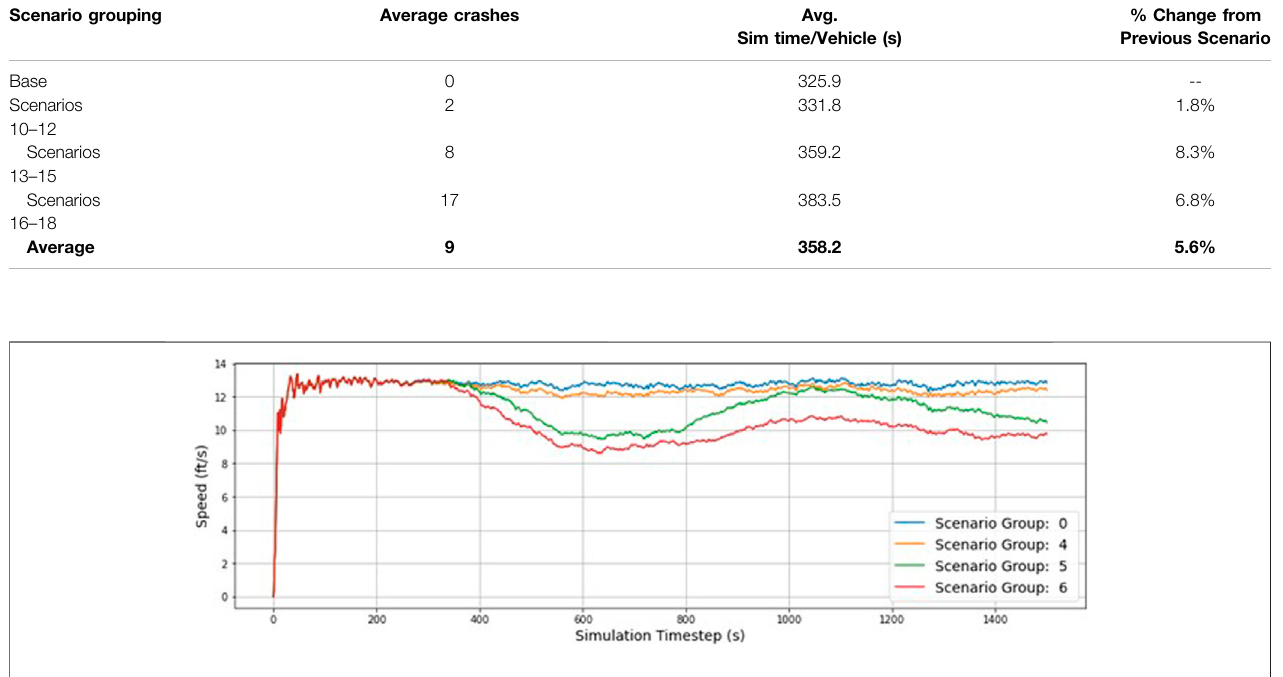
FIGURE 6 | Vehicle speed per time step — MITM